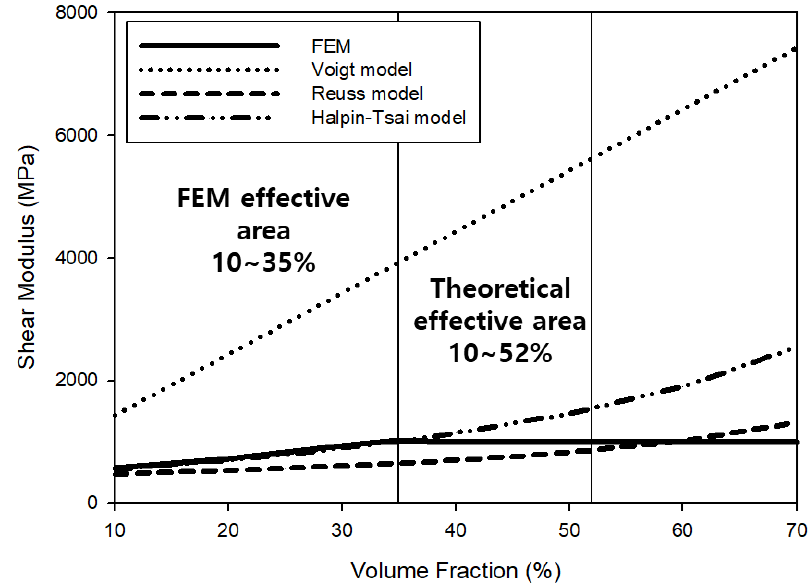
Figure 4. Values of shear modulus according to the volume fraction predicted by various models: Voigt, Reuss, Halpin–Tsai, and the finite element method (FEM).